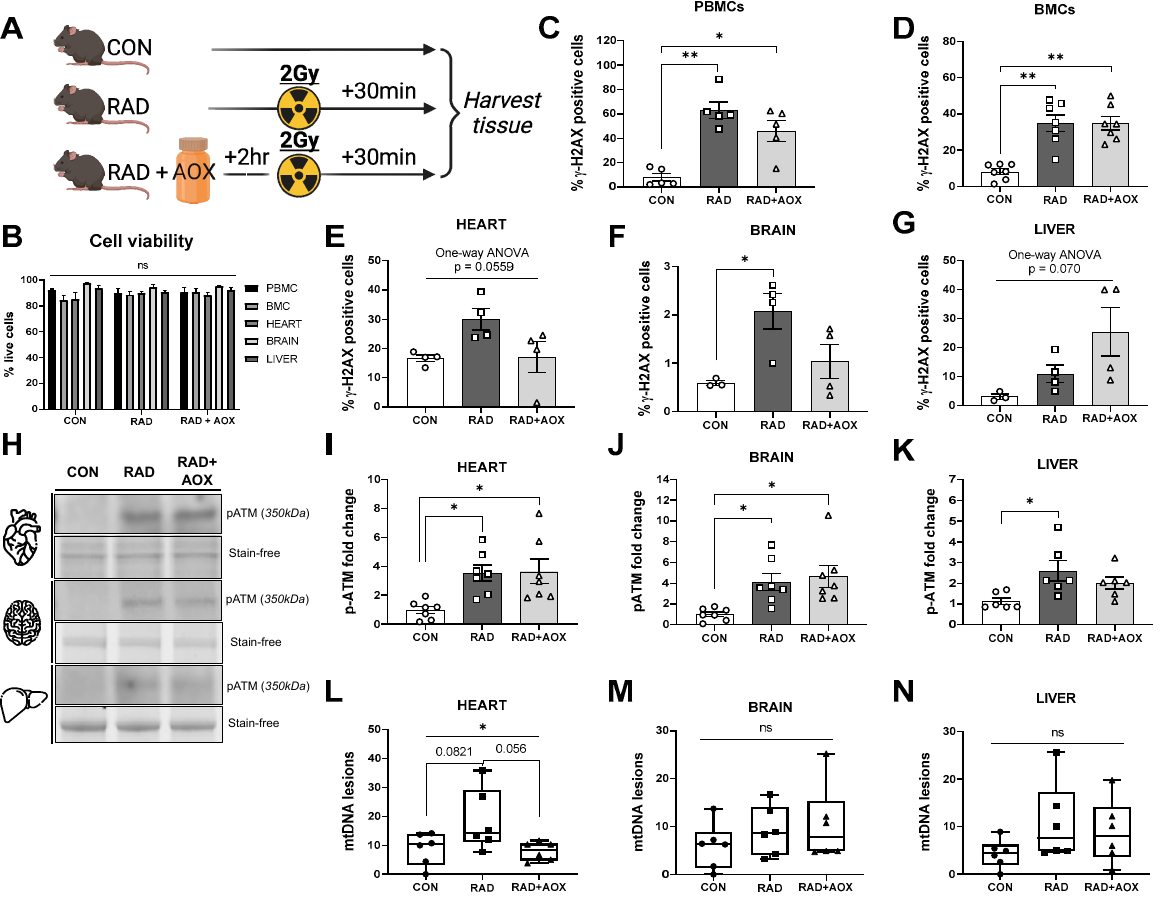
Figure 1. Ionizing radiation causes DNA damage across multiple tissues in mice. ( A ) Design of experiment. Mice were harvested 30 min following 2 Gy radiation. 2 h prior, mice were gavage fed with vehicle placebo (RAD) or antioxidant (RAD + AOX). Control mice (CON) were not gavage fed or irradiated. Flow cytometry of ( B ) viable cells, stained for γ -H2AX were analyzed and represented as % of positive cells in ( C ) Peripheral blood mononuclear cells (PBMCs), ( D ) Bone marrow cells (BMCs) ( E ) heart, ( F ) brain, and ( G ) liver. ( H ) Representative Western blot images for p-ATM protein expression and densitometric quantification in the ( I ) heart, ( J ) brain and ( K ) liver. Protein expression data is expressed as fold change mean ( ± SEM) relative to CON. ( L – N ) mtDNA lesions were analyzed and graphed through LORD-Q assay. Individual data points shown. Statistical analysis was done with One-way ANOVA with Tukey’s post hoc. *, ** denote a significant difference between groups of p < 0.05, and p < 0.01,